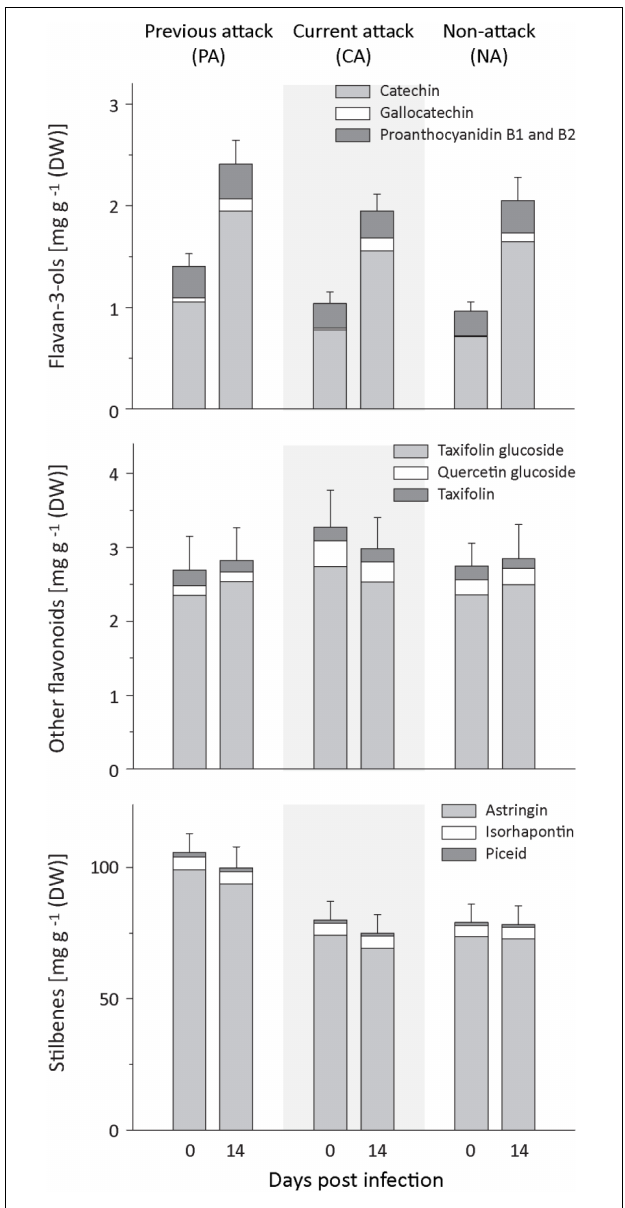
FIGURE 3 | Induction of phenolic compounds in spruce bark after Endoconidiophora polonica infection. The concentration of flavan-3-ols (upper panel) , other flavonoids (middle panel) , and stilbenes (lower panel) were quantified by LC-MS/MS analysis from bark tissue harvested before and 14 days after infection with E. polonica . Trees investigated: (1) were from a stand with a history of previous bark beetle attack, but no current attack (PA), (2) were under current attack, but had no previous history of attack (CA), or (3) had no previous nor current attack (NA). Data are means ± SD of measurements from 6 to 19 biological replicates; exact numbers are given in the Section “Materials and Methods.” Statistical values for individual compounds are given in Supplementary Tables 4, 5